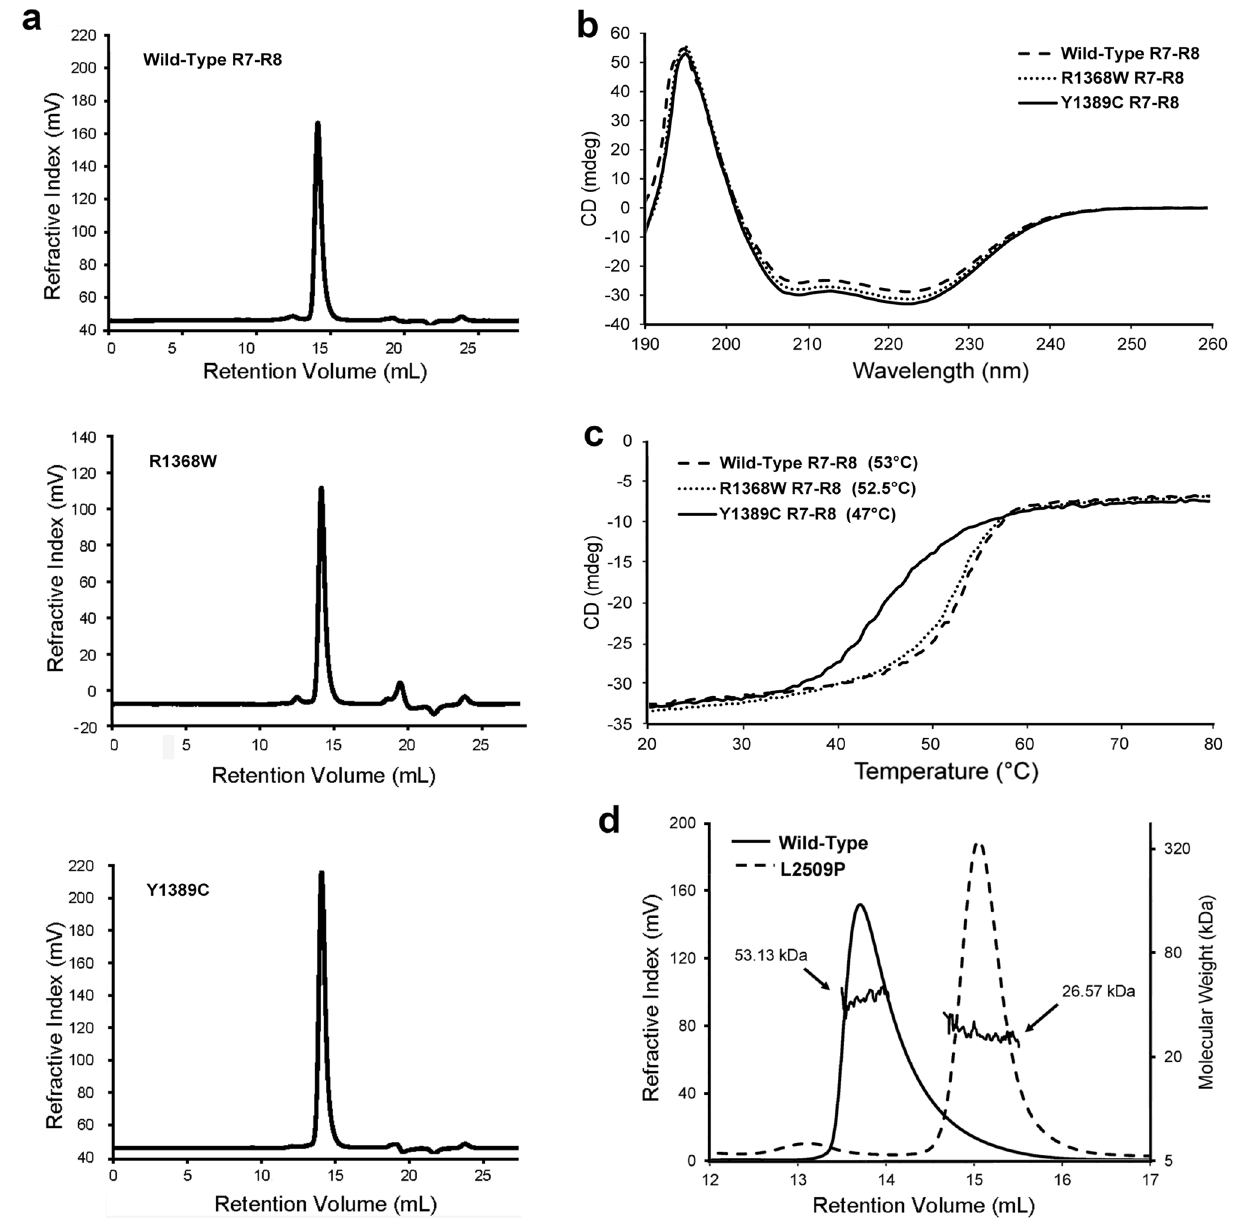
Figure 3. Influence of point mutations on biophysical properties of talin. ( a ) Full SEC profile of R7–R8 WT, R7–R8 R1368W and R7–R8 Y1389C showing the monomeric state. ( b , c ) CD analysis of R7–R8 WT, R7–R8 R1368W and R7–R8 Y1389C. ( b ) CD spectra of each mutant. ( c ) Melting temperature curves; the melting temperature of each protein is shown. ( d ) SEC–MALS analysis of R13–DD WT and R13–DD L2509P showing that the R13–DD L2509P is monomeric. The molecular weight obtained from MALS is shown for each were constant (Supplementary Fig. S3a,e). The adhesion size and abundance were analysed from the cell periph- ery and did not reveal significant changes in either the adhesion area or adhesion number with the various talin mutations (Supplementary Fig. S4b,c). To evaluate the effect the mutations have on cell morphology, we visualised talin and vinculin in transfected fibroblast cells devoid of talins (Fig. 4a) and quantified the effect of the mutations on cell area and circularity (Supplementary Fig.S4d,e). The mutations caused little variance on cell morphology when compared to WT, except for cells carrying the dimerisation domain (DD) mutation L2509P, which were significantly smaller than the WT expressing cells and showed a more circular cell phenotype (Supplementary Fig. S4d,e), indicating a loss in cell polarisation. We next assessed the levels of vinculin, and paxillin within the talin-1 rich adhesion sites with the aid of immunofluorescence labelling and confocal imaging (Fig. 4b,c), and assessed the total level of phosphoryl- ated FAK in cells via western blotting (Fig. 4d; Supplementary Fig.S3f). FAK phosphorylated at tyrosine 397